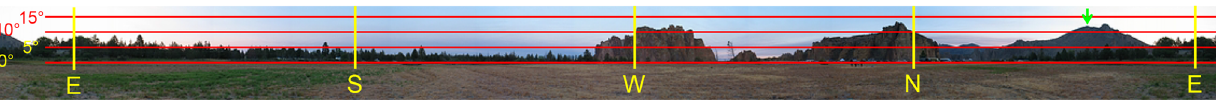
Figure 1. Panorama as seen from instrument location. Mountains are located in the west (W), north (N), and northeast and extend up to 12.5 ◦ above the horizon. Trees restrict the horizon in eastern (E) direction by up to 9 ◦ . There is little ( < 5 ◦ ) obstruction towards the south (S). The green arrow marks the mountain used for calibrating the elevation scale (red lines).